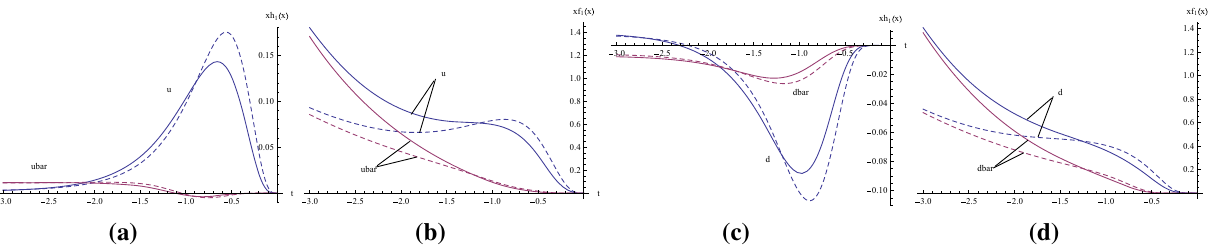
60GeV, respectively. a and c are for transversity PDFs, while b and d are for unpolarized PDFs. x = 10 t in each diagram